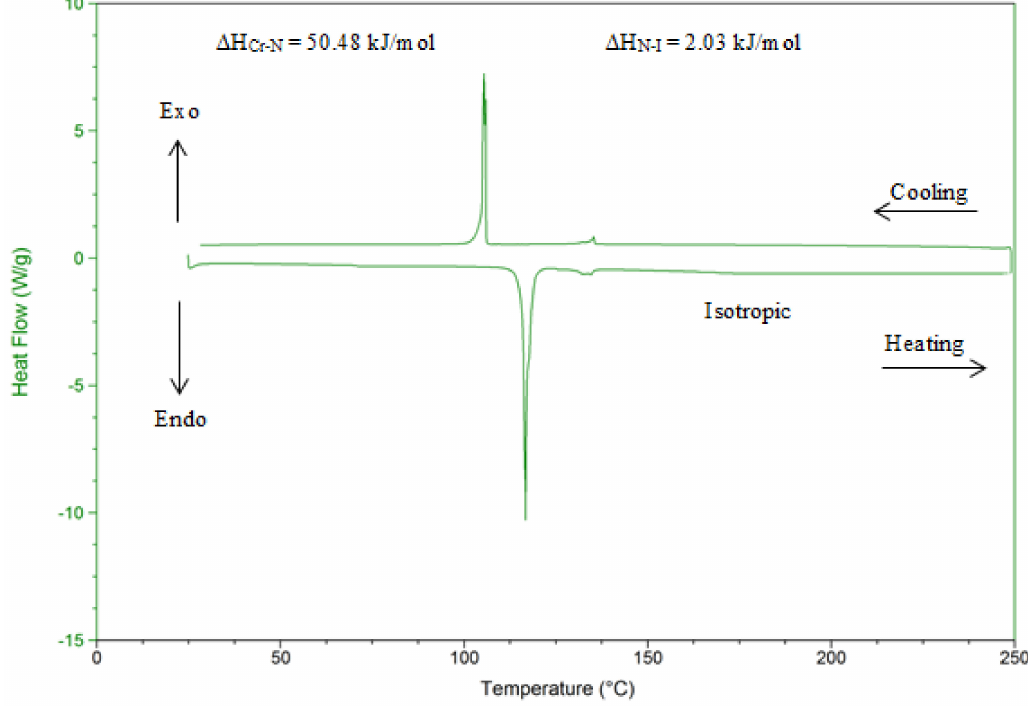
Figure 3. Differential scanning calorimetry (DSC) thermogram of compounds I C 8 during heating and cooling cycles, at 10.0 ◦